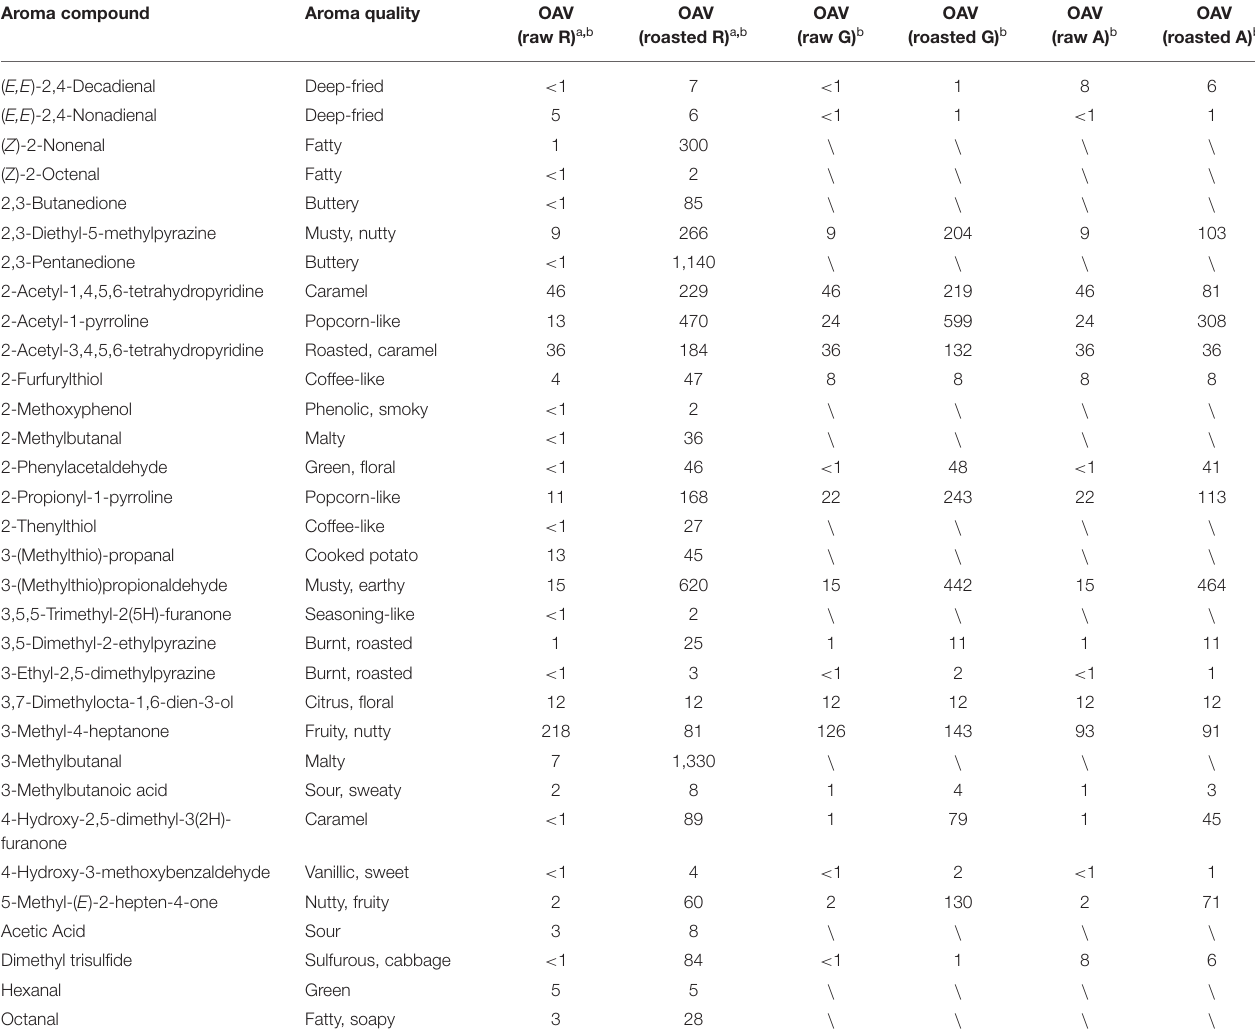
TABLE 6 | Key-aroma compounds are defined through the sensomics approach in raw and roasted hazelnut samples from cultivars Tonda Gentile Trilobata (G), Tonda Gentile Romana (R), and Akçakoca blend (A). Aroma